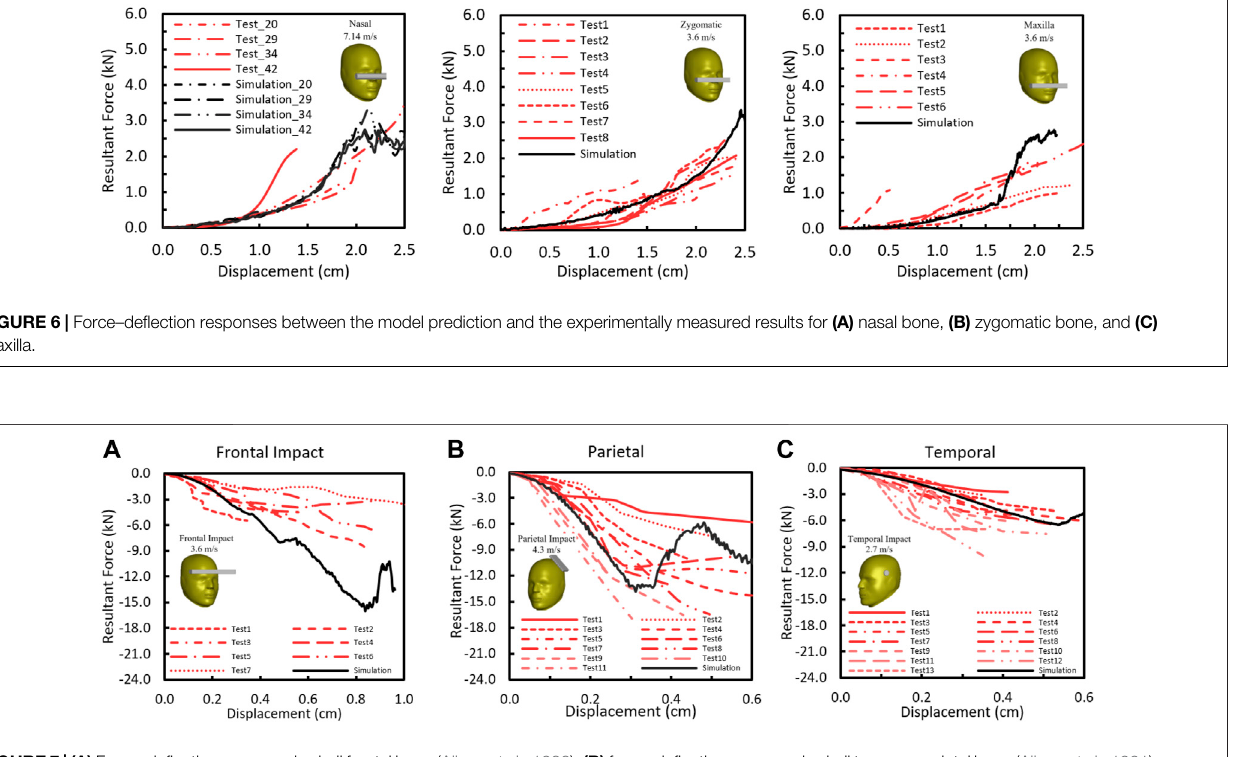
Frontiers in Bioengineering and Biotechnology |